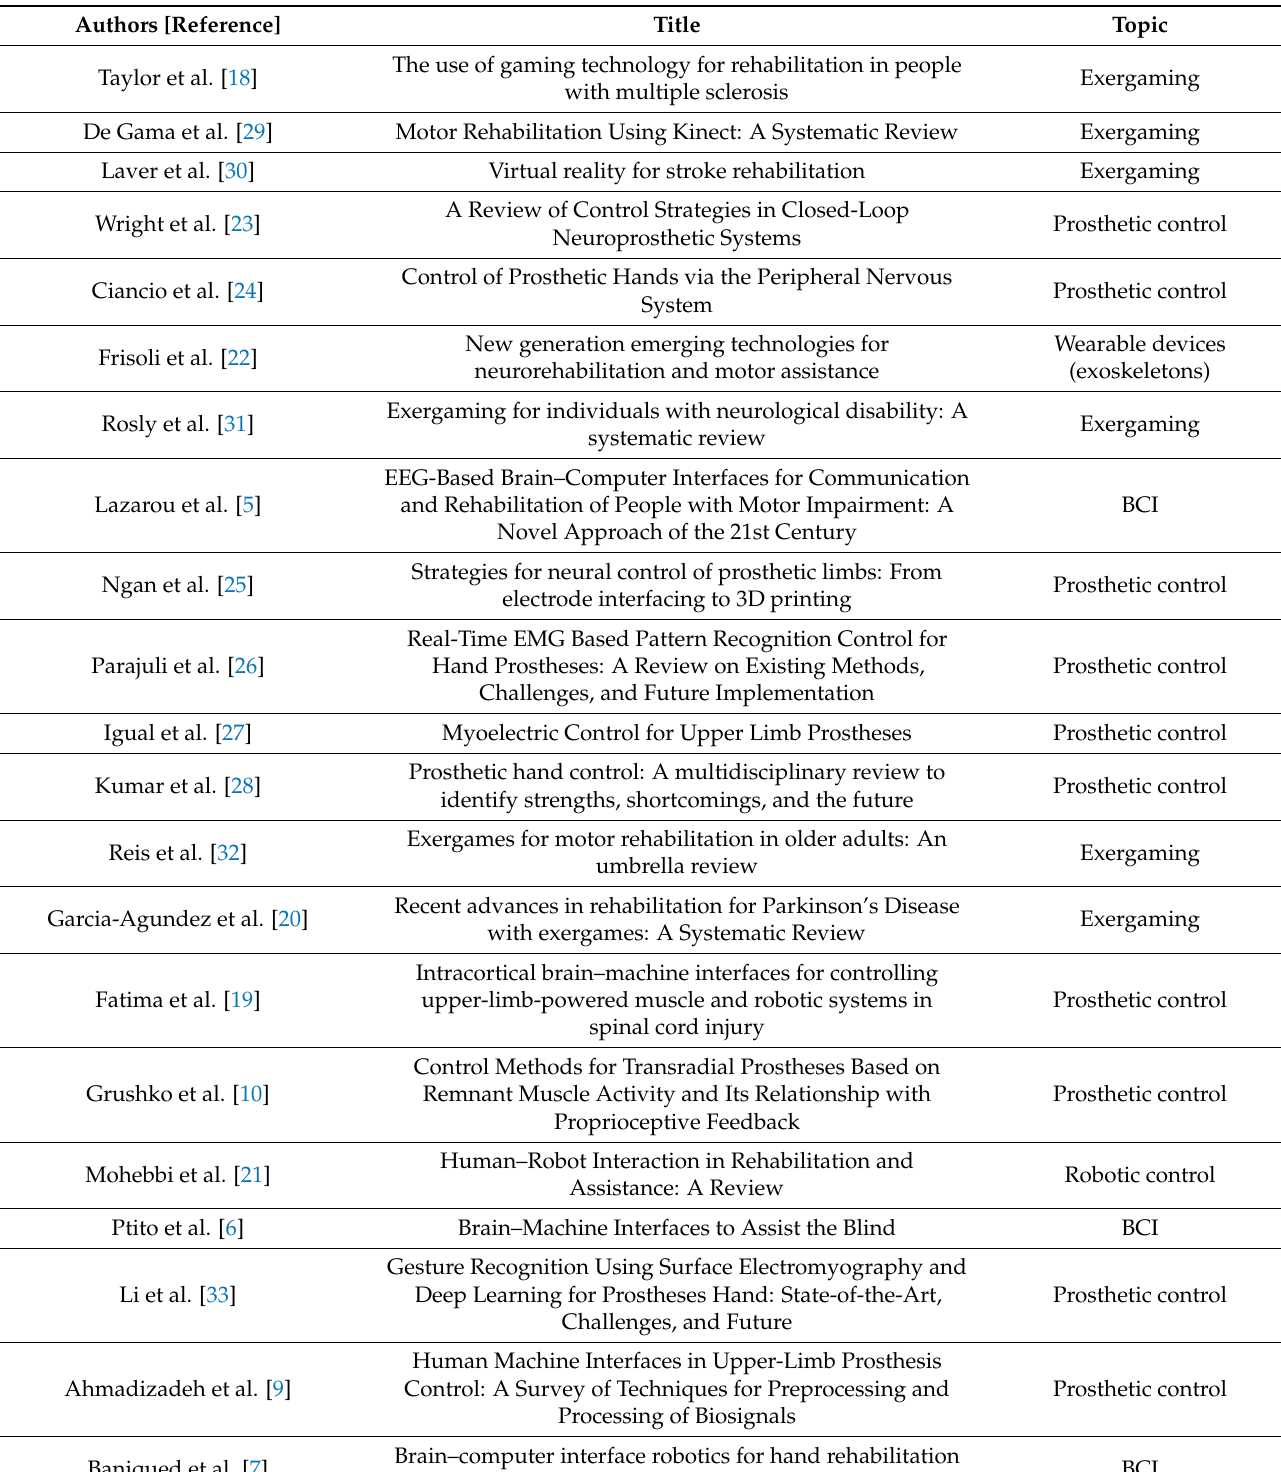
Table 1. Review studies about HMIs for assistive and rehabilitation purposes (starting from 2015 to